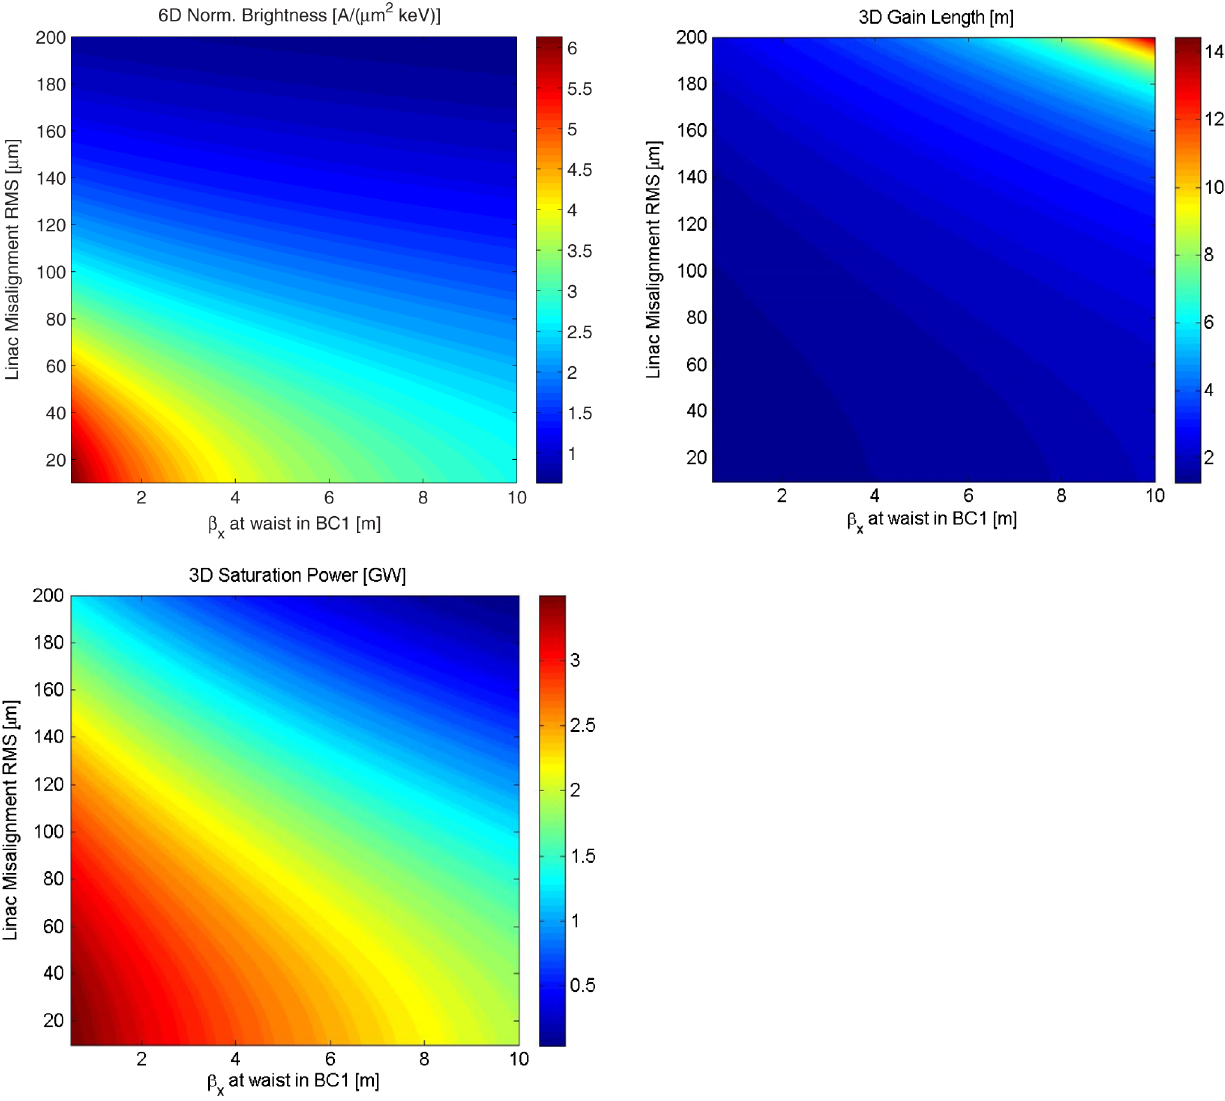
FIG. 9. Contour plot of B (top left), L (top right), and P as a function of the rms linac-to-beam misalignment and of the n; 6 D g; coll sat ; coll minimum betatron function in BC 1 . A 500 pC bunch charge, compressed in one stage by a factor of 18 in the SL linac, was considered. The final peak current is 0.9